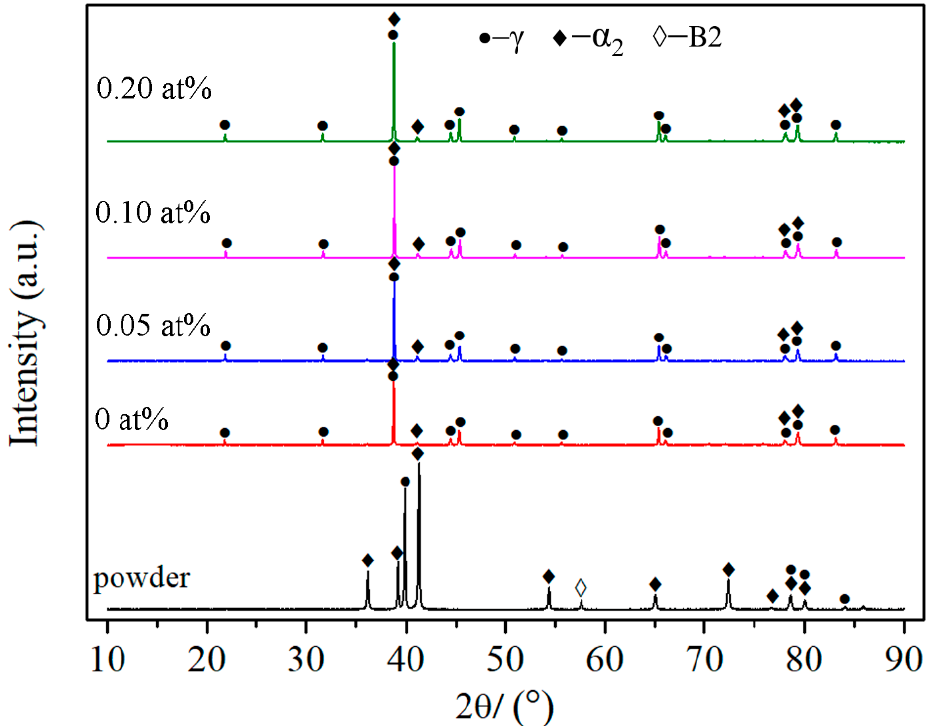
Figure 2. XRD pattern of pre-alloyed powders and four alloys with different content of nano-Y 2 O 3 . Figure 3 shows the SEM-BSE microstructures of the experimental alloys with different content of nano-Y 2 O 3 addition. It was found that the microstructure of Ti-47.7Al-7.1Nb- 1.1Cr-2.3V alloy consisted of γ + α 2 lamellar and a few γ , α 2 , and B2 phases around the boundaries of the lamellar colonies or in the γ + α 2 lamellar without addition nano-Y 2 O 3 as shown in Figure 3a,b. With 0.05 at% of Y 2 O 3 addition, the sample showed a duplex microstructure including half approximately of the lamellar colony and more equiaxed γ phase exhibited in Figure 3c. Due to the nano-Y 2 O 3 particles being distributed on the surface of pre-alloyed powders after ball milling, the Y 2 O 3 particles displayed an obvious network structure in the TiAl matrix. It can be seen from Figure 3d that most of the still Y 2 O 3 nanoparticles and a few of the micro-scale precipitates were in the TiAl matrix with the 0.05 at% nano-Y 2 O 3 addition. The Y 2 O 3 particles were dispersed in the γ phase, lamellar colony, and colony boundary. Obviously, with the content of Y 2 O 3 increasing from 0.05 to 0.20 at%, the microstructure of the sintered sample changed from duplex to near lamellar as shown in Figure 3c,e,g. However, more micro-scale Y 2 O 3 particles were observed, as shown in Figure. After 3 h, the content of nano-Y 2 O 3 increased to 0.20 at%, due to the additional Y 2 O 3 particles distributed on the surface of the pre-alloyed powders after ball milling during the sintering process and additional particle agglomeration and grow